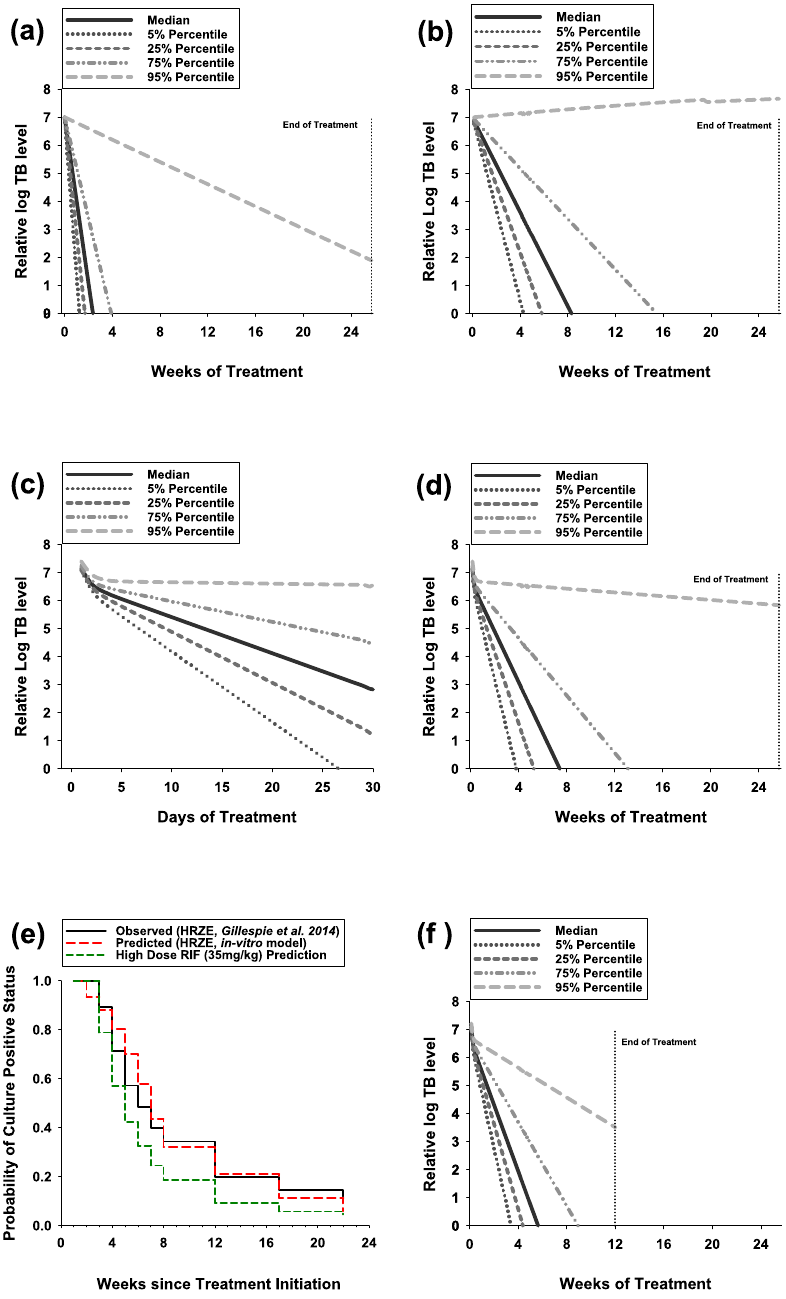
Figure 4. PK-PD Monte-Carlo simulations of clinical Mtb response based on concentration-kill rate dynamics derived from in vitro models of intracellular and extracellular Mtb . ( a ) Predicted dynamics of total TB in patients receiving HRZE combination for 6 months based on extracellular kill rates only. ( b ) Predicted dynamics of total TB in patients receiving HRZE combination for 6 months based on intracellular kill rates only. ( c ) Predicted dynamics of total TB in patients receiving HRZE combination for 6 months based on the assumption that extracellular TB constitutes 95% and intracellular 5% of total TB (1-month view). ( d ) Predicted dynamics of total TB in patients receiving HRZE combination for 6 months based on the assumption that extracellular TB constitutes 95% and intracellular 5% of total TB (6-month view). ( e ) Probability of sputum sample conversion to Mtb culture-positive status over time as observed in TB patients receiving standard HRZE treatment in a previous clinical study 7 (solid black line) compared to the predicted probabilities over time using our novel PK-PD model (dashed red line). Dashed green line shows our PK-PD prediction when using a standard HRZE regimen but with an elevated dose of RIF (35 mg/kg). The comparison assumes that the limit of detection for positive culture conversion is 10 CFU/mL when using Löwenstein–Jensen medium culture assays 67 which have been implemented in the comparator clinical study. ( f ) Predicted dynamics of total TB in patients receiving HRZE with a high dose of RIF (35 mg/kg) for 3 months on the assumption that extracellular TB constitutes 95% and intracellular 5% of total TB (6-month